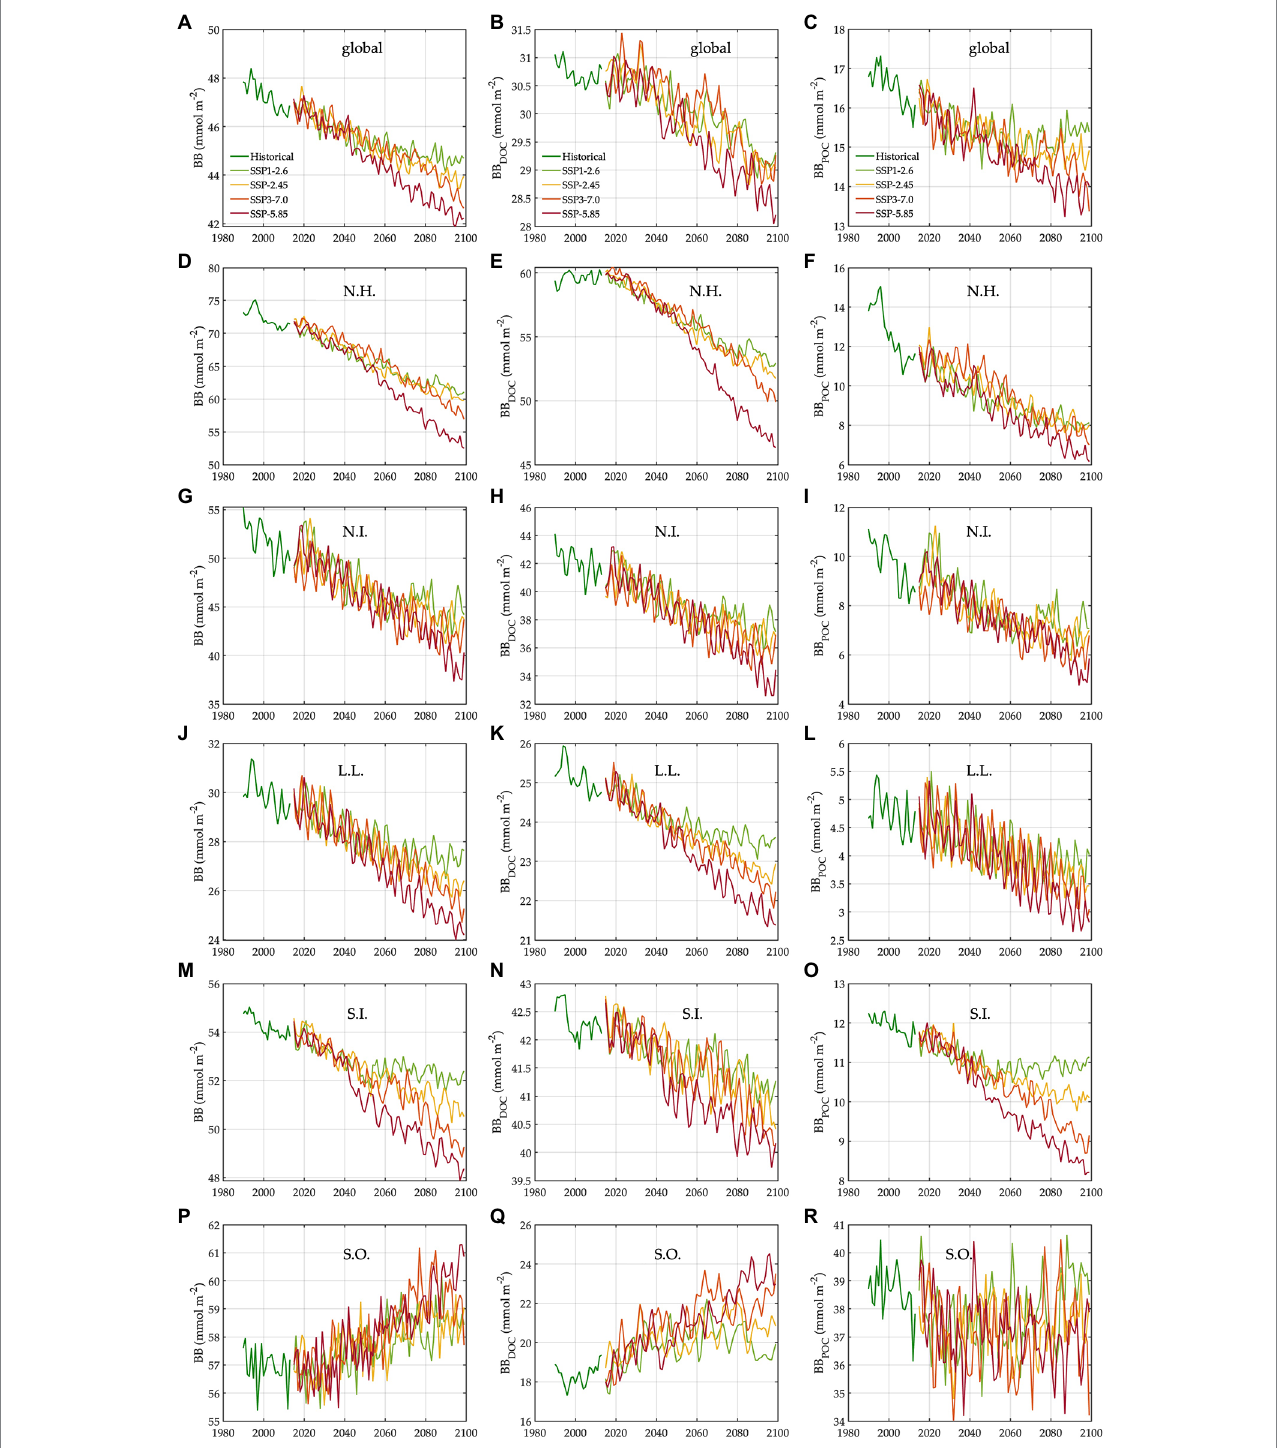
FIGURE 3 Trends in bacterial carbon biomass under different climate change scenarios. N.H.: northern high latitudes, N.I.: northern intermediates, L.L.: low latitudes, S.I.: southern intermediates, and S.O.: Southern Ocean. The trends (1990–2099) in bacterial carbon biomass in the global ocean (A) , N.H. (D) , N.I. (G) , L.L. (J) , S.I. (M) , and S.O. (P) . The trends (1990–2099) in carbon biomass of free-living bacteria in the global ocean (B) , N.H. (E) , N.I. (H) , L.L. (K) , S.I. (N) , and S.O. (Q) . The trends (1990–2099) in carbon biomass of particle-attached bacteria in the global ocean (C) , N.H. (F) , N.I. (I) , L.L. (L) , S.I. (O) , and S.O. (R)